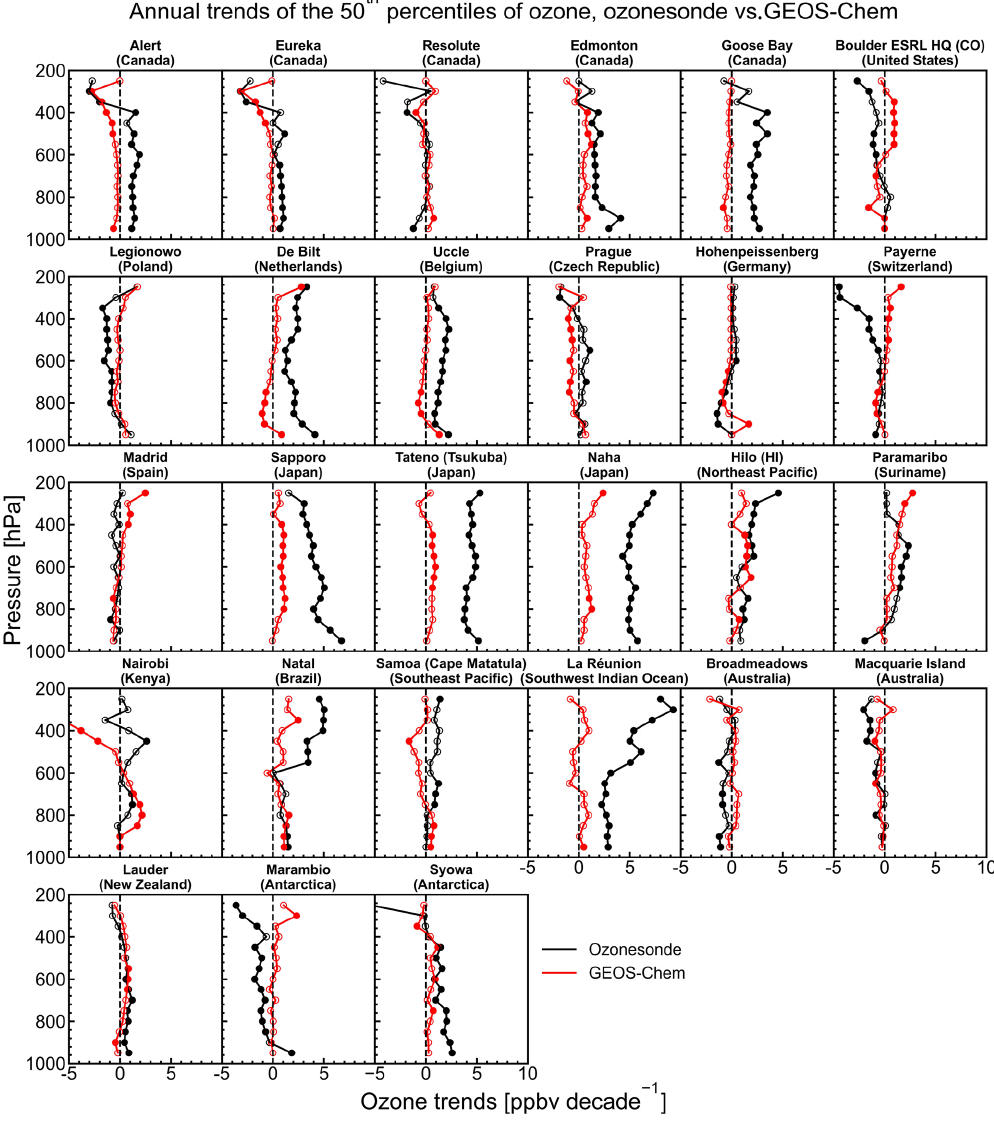
Figure 6. Same as Fig. 5 but for the comparison of ozonesonde vs. GEOS-Chem